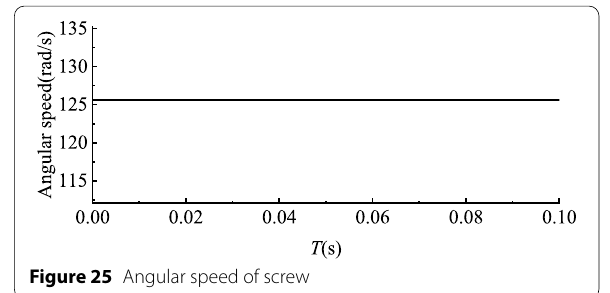
Figure 25 Angular speed of screw